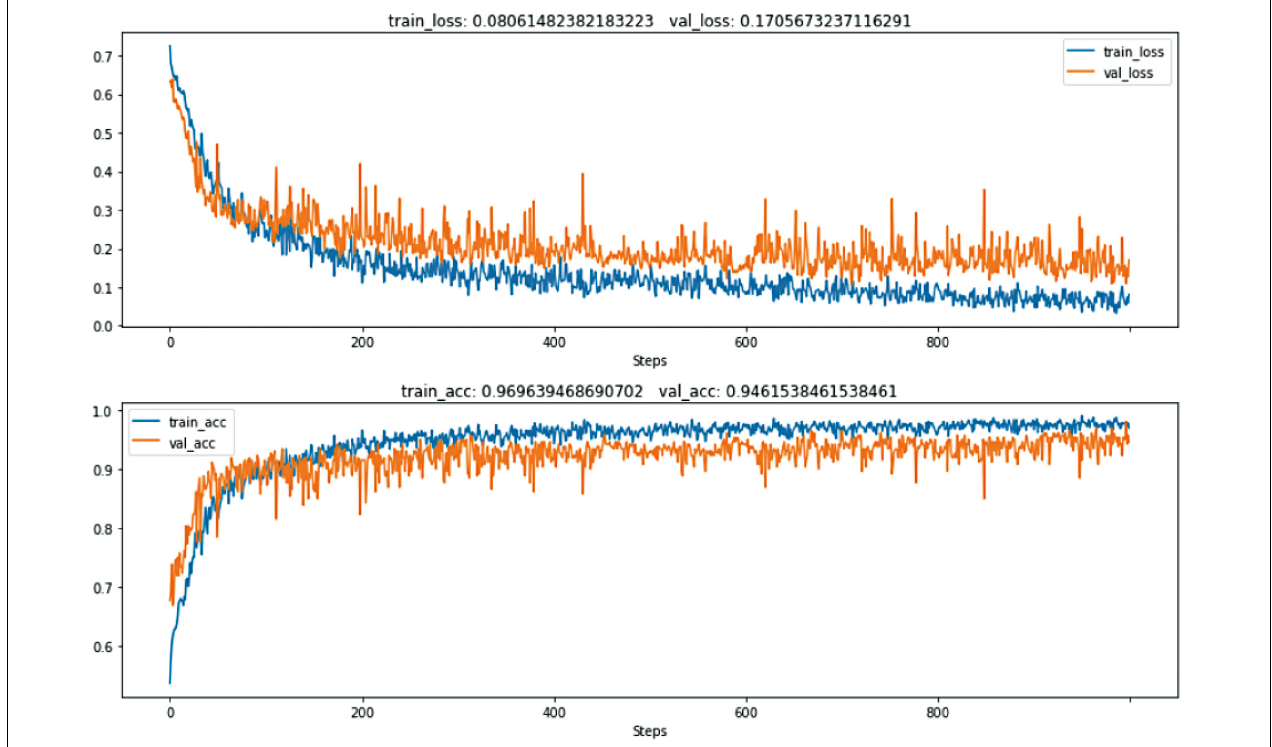
FIGURE 3 | The 1000 epochs of the training process.